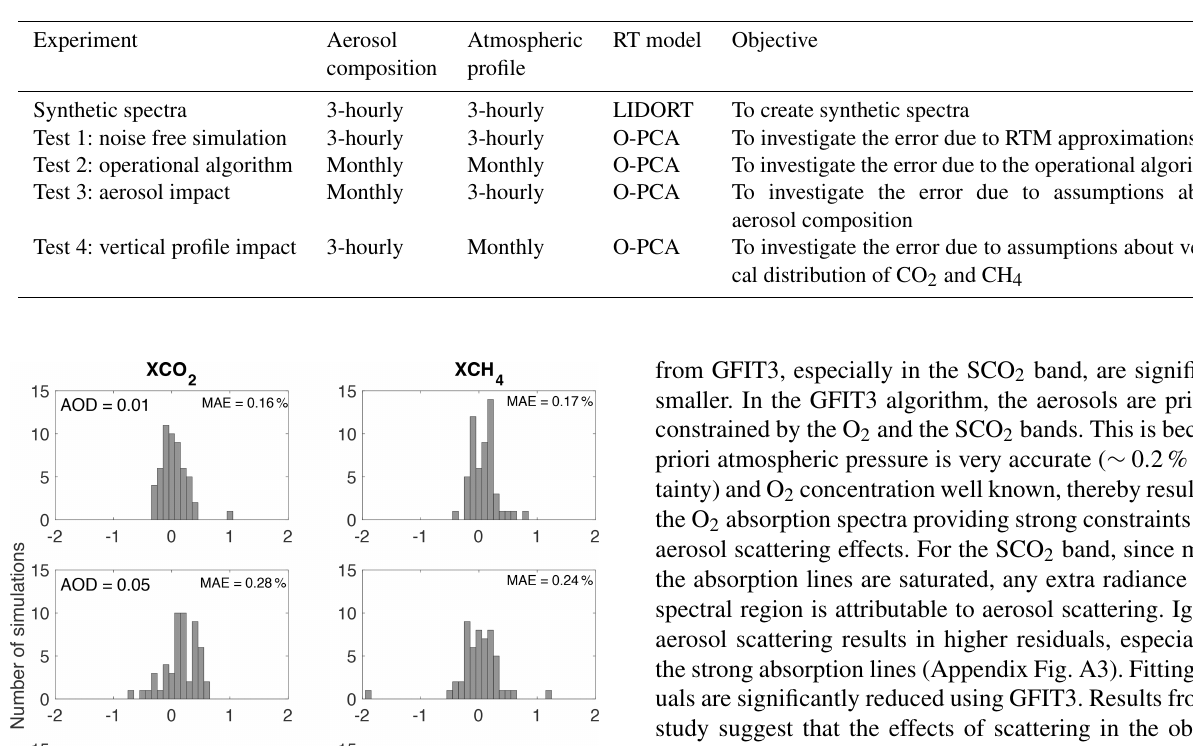
Table 2. Synthetic experiments to assess the impact of RTM, aerosol composition, and GHG profiles on retrievals of XCO 2 and XCH 4 from CLARS-FTS observations.